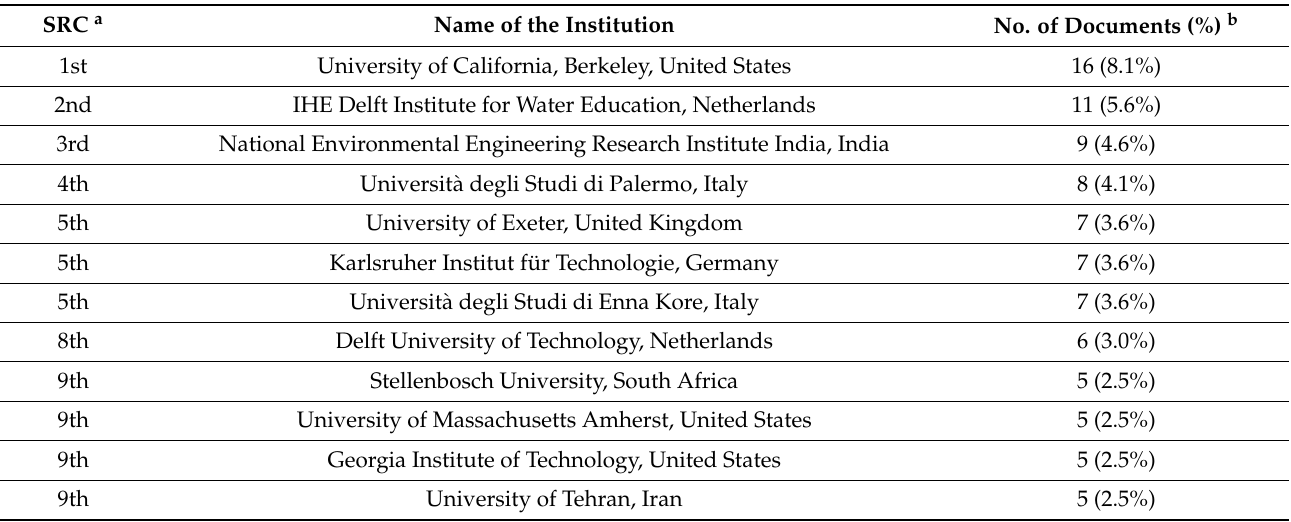
Table 3. Top 10 most-productive institutions regarding intermittent water supply systems (IWSS) research